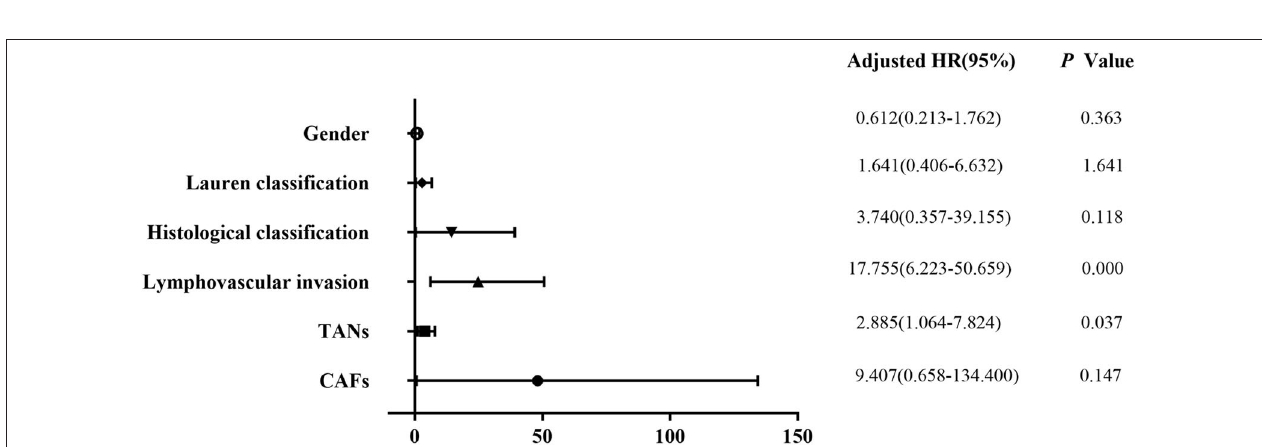
FIGURE 2 | Multivariate logistic regression analysis of potential risk factors for LNM in patients with EGC. Histological classification ( P = 0.026), LVI ( P = 0.000), and TANs ( P = 0.013) were the independent risk factors for LNM in the patients with EGC.